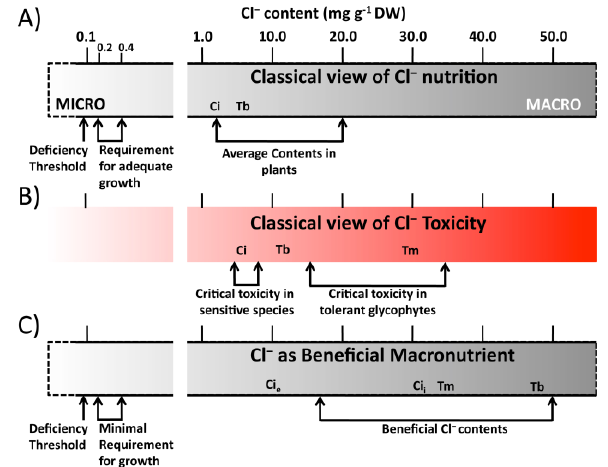
Figure 1. Cl − homeostasis in glycophyte plants. Schematic illustration of Cl − homeostasis in glycophyte plants according to the classical view of Cl − nutrition ( A ), the classical view of Cl − toxicity ( B ), and comparison with the recently proposed role of Cl − as a beneficial macronutrient in glycophyte plants ( C ). ( A,B ) have been made from the data of Cl − contents reported in different plant species, obtained from the review by Xu et al. [5]. Cl − homeostasis as a beneficial macronutrient in glycophyte plants is illustrated in ( C ), according to the data recently reported [2,18 – 20]. Ci, citrus; Tb, tobacco; Tm, tomato; Ci e , citrus excluder genotypes; Ci i , citrus includer genotypes.